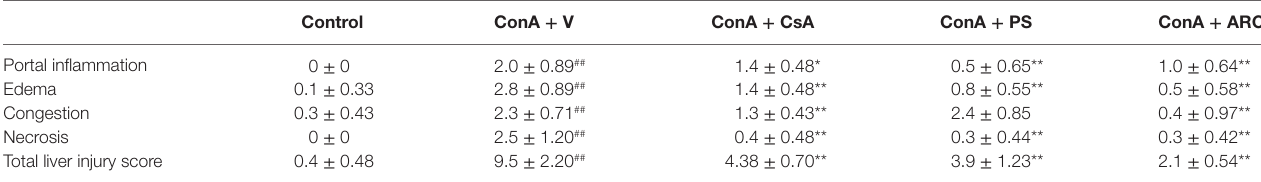
TaBle 3 | Components and total values of liver injury